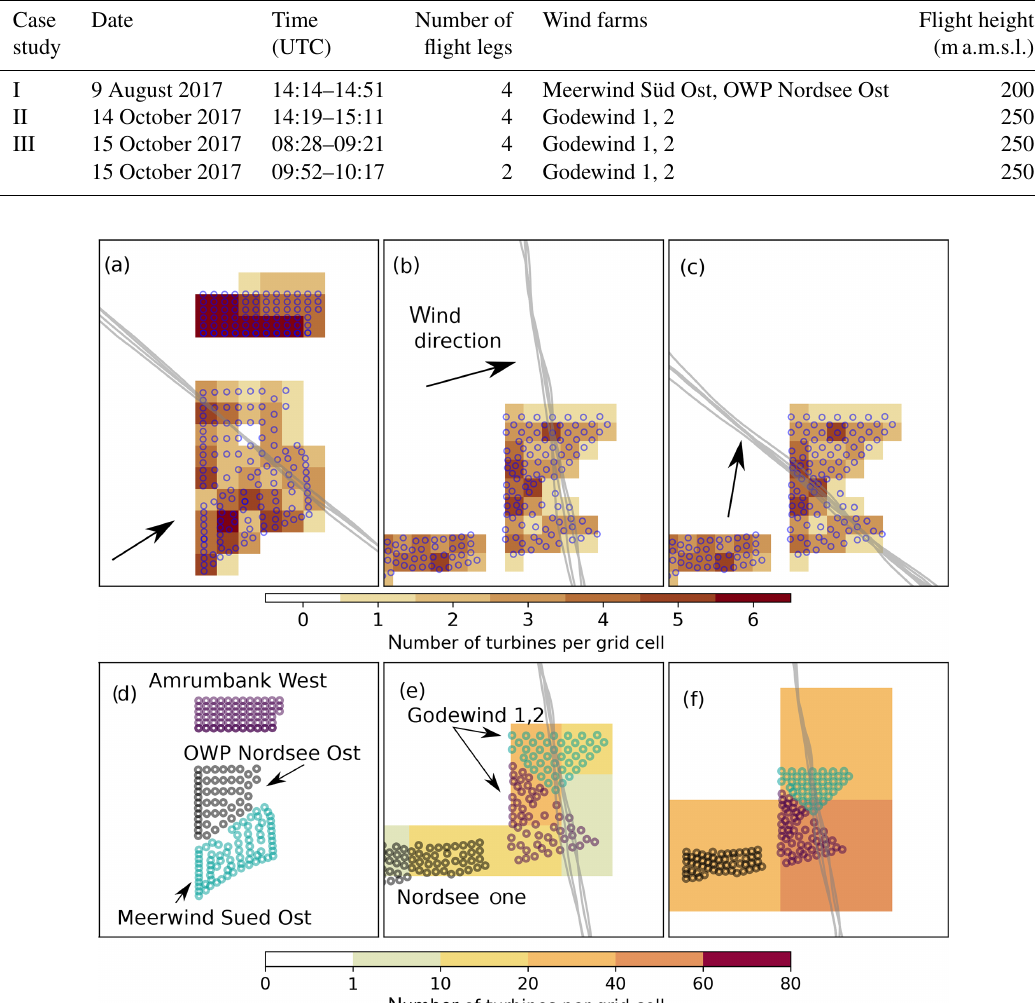
Figure 2. The number of wind turbines within one grid cell in colored contours for the wind farms: (a) Meerwind Süd Ost (MSO) and OWP Nordsee Ost (ONO) and (b–c) Godewind Wind 1, 2 (GW) for the control simulations (CNTRa, CNTRb, CNTRc). The size of the contour areas corresponds to the size of the horizontal model grid. The circles denote the exact locations of the single wind turbines, whereby the wind turbines are colored according to the wind farm they belong to in panels (d) – (f) ; additionally, panels (e) – (f) show the horizontal grid with 5 and 16km resolution for the following sensitivity studies: DX5, DX16, DX5noTKEsource and DX16noTKEsource (see Table 2 for an overview of all simulations). The wind turbines are not colored in panels (a) – (c) for better visibility of the wind turbine density. The gray lines denote the flight track of the research